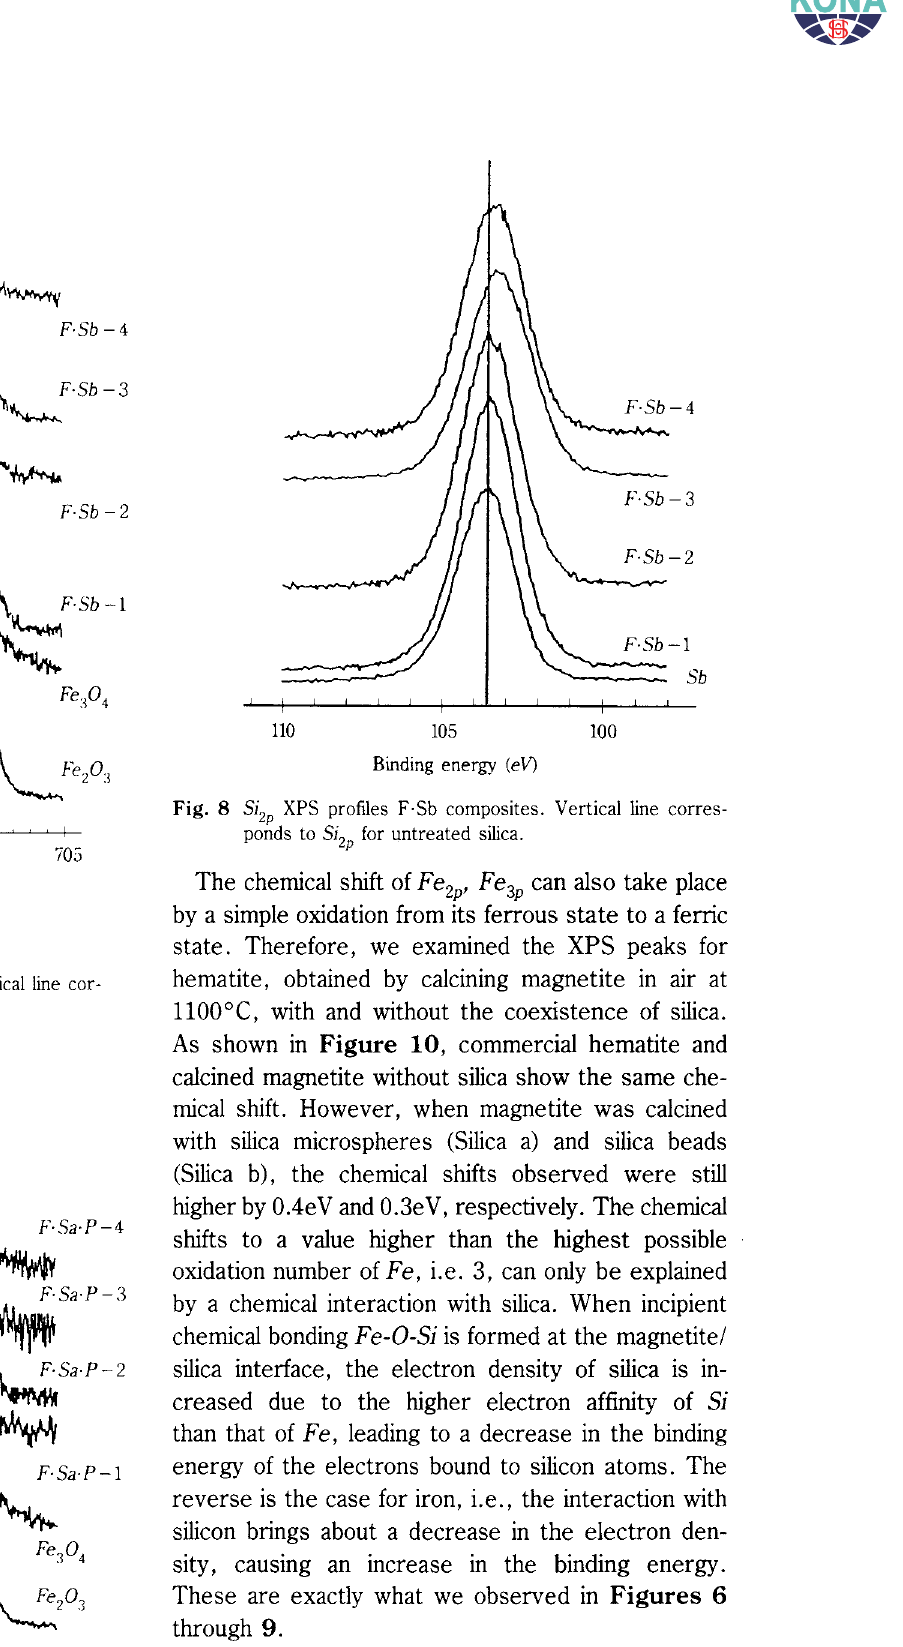
Fig. 7 Fe 2P XPS profiles for F·Sa·P composites with double guest layers. Vertical line corresponds to F e 2P312 for untreated magnetite.